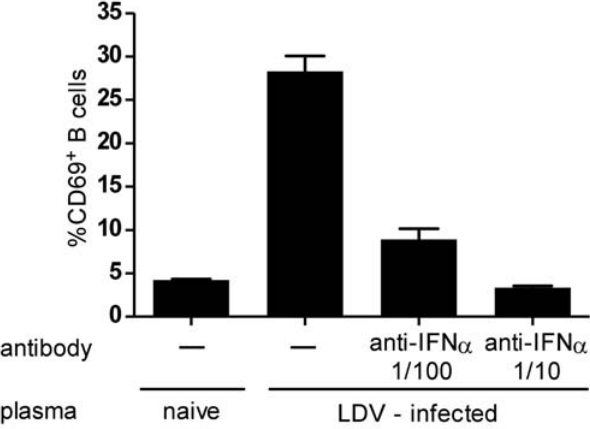
Figure 2. CD69 upregulation in B cells blocked by anti-IFN a antibody. The addition of 10% serum from LDV-infected mice harvested at 16hpi induced upregulation of CD69 in a significant percentage of splenic B cells (2 6 10 5 B cells/well) cultured in vitro for 4 hours following their isolation with CD19 magnetic beads (Miltenyi Biotec). Addition of 2 or 20 m l of anti-IFN a antibody (PBL Interferon Source) to 198 or 180 m l cultures respectively, significantly reduced the percentage of cells with CD69 upregulation (P # 0.0001 by t test).